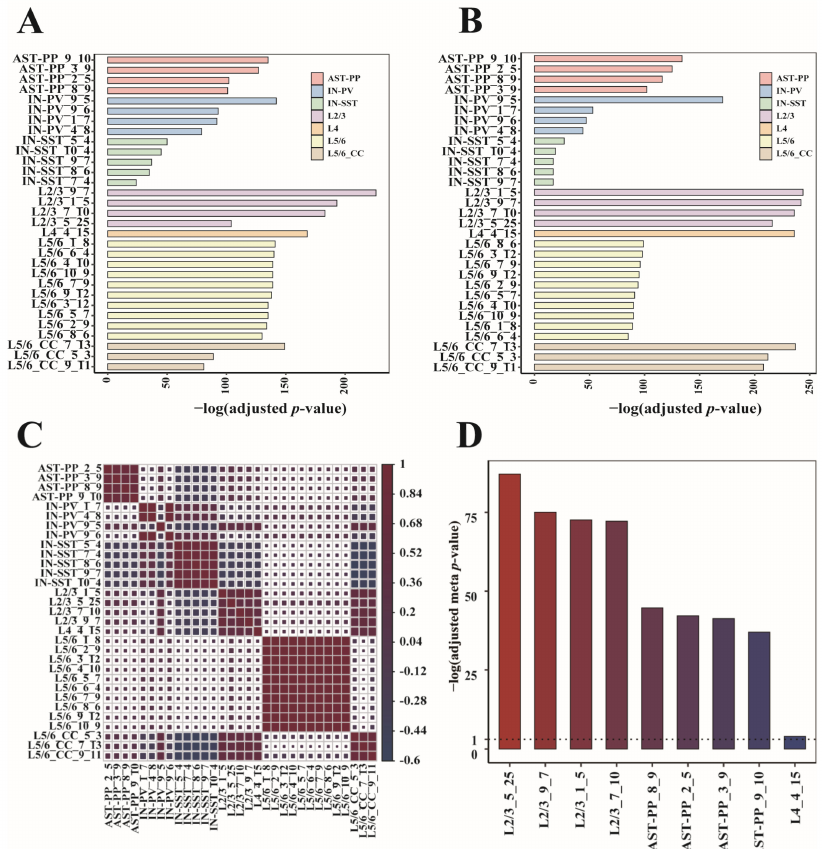
Figure 4. Enrichment and correlation analysis of the 31 cell-type-specific ASD-associated gene modules. The bar plot of − log 10 (adjusted p -values) of enrichment analysis between each gene module and ( A ) cell markers and ( B ) Simons Foundation Autism Research Initiative (SFARI) genes. ( C ) The Spearman correlation diagram of the 31 modules. ( D ) The − log 10 (adjusted meta p -values) of cell-type-specific ASD-associated gene modules that significantly correlated with clinical severity of